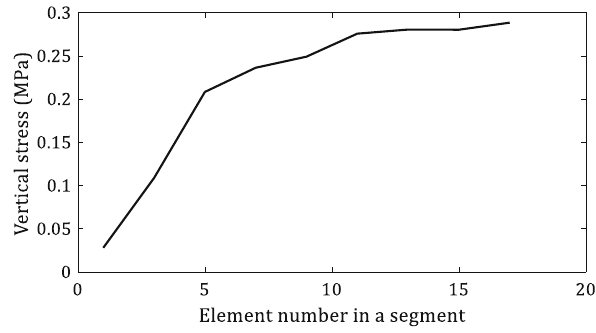
Fig. 12 Maximum vertical stress against the element number in a tunnel